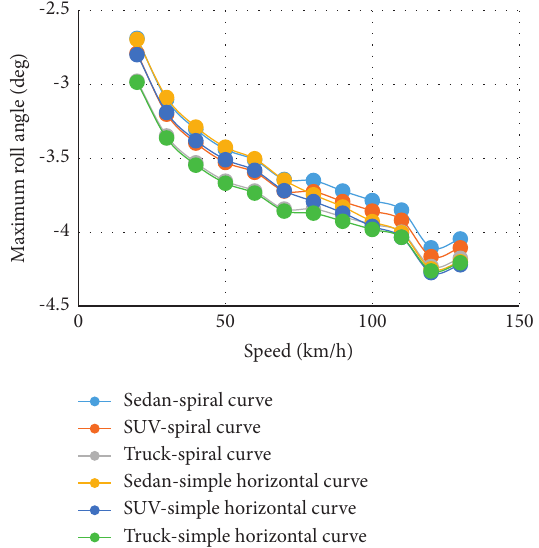
Figure 19: Maximum roll angle versus the speed in the simple and spiral horizontal curves at radius R